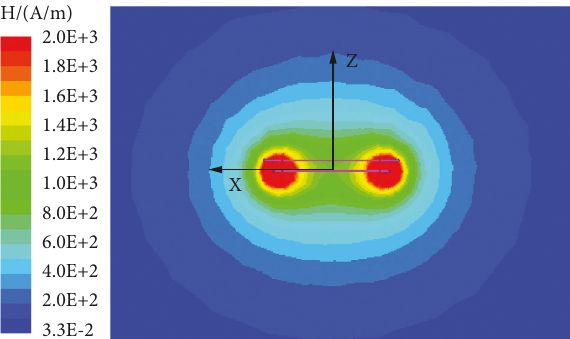
Figure 7: XZ plane magnetic field intensity distribution.